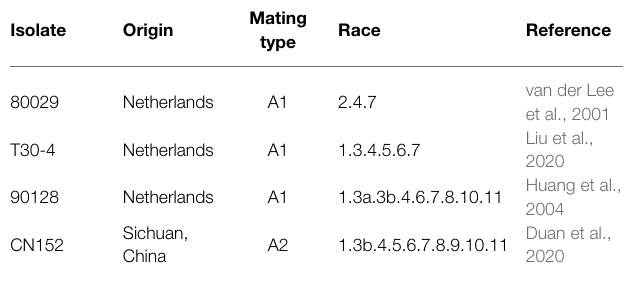
TABLE 2 | The isolates of Phytophthora infestans used in this study.